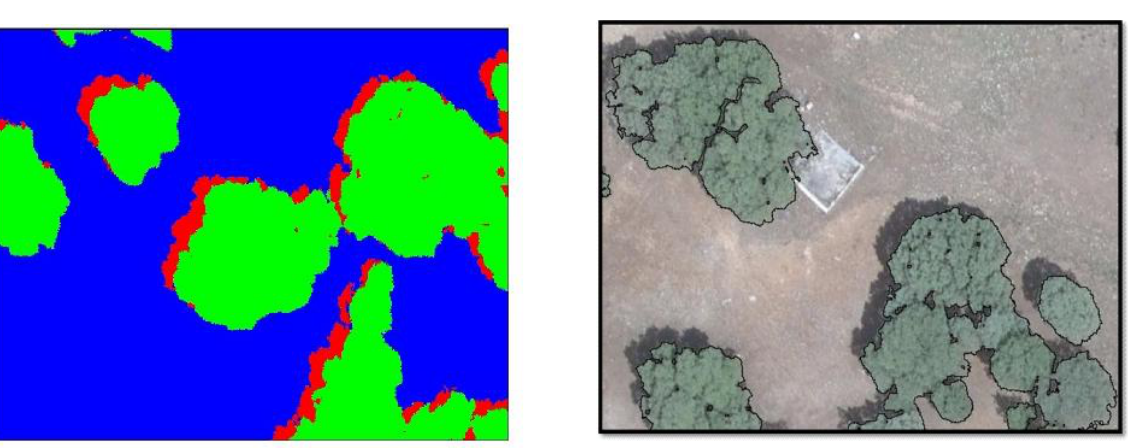
Figure 5: Three classes of tree crowns (green); tree shadows (red) and woodland floor (blue).